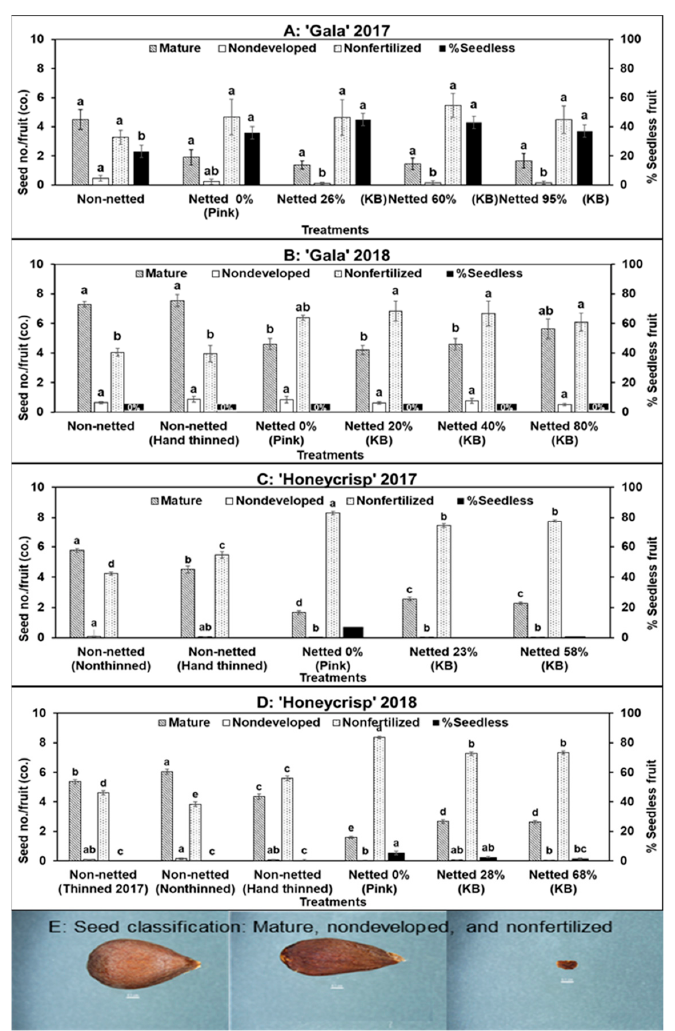
Figure 3. Effect of 2017 and 2018 netting treatments on number of mature, nondeveloped and nonfertilized seeds, and the percentage of seedless fruit of ‘Gala’ ( A , B ) and ‘Honeycrisp’ ( C , D ) using classifications of mature, nondeveloped and nonfertilized seeds ( E ) from left to right, respectively. Vertical bars in A and B represent SE ( n = 100 to 1200). Mean separation among treatments by Tukey HSD ( P < 0.05), whereby means associated with different letters are significantly different. (Pink) pink stage of bud development. (KB) king flower bloom. For ( E ), all seeds were imaged at 7.5 × ; horizontal bars below seeds represent 0.1 cm.